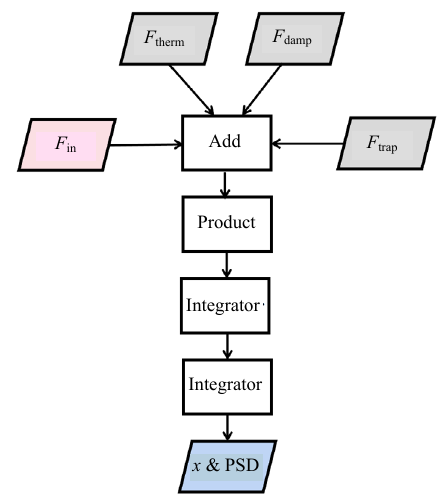
Fig. 2 Simulation flow chart.